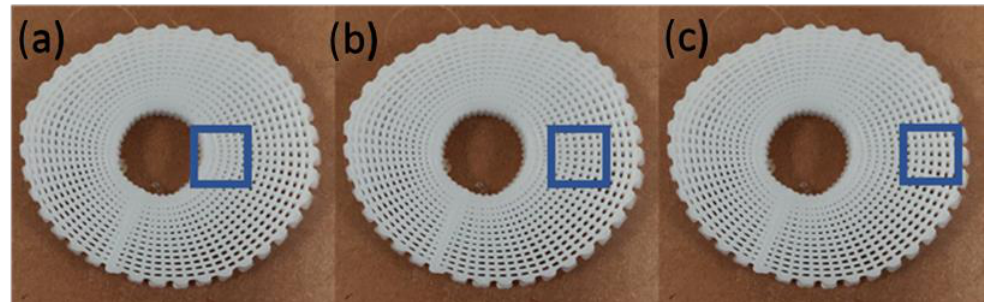
Figure 3. The different regions for the water contact angle tests: ( a ) the internal region; ( b ) the central region; and ( c ) the external region.